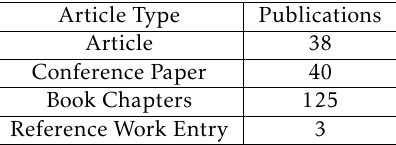
Table 4. Publications per year in